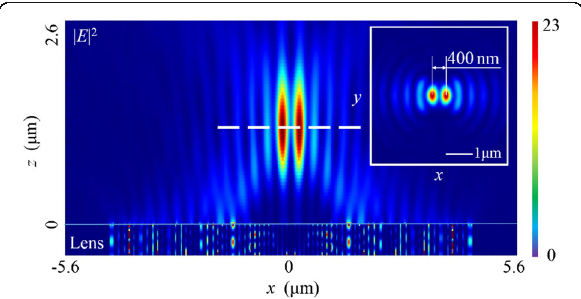
Fig. 3 Intensity distribution pattern of the total electric field | E | 2 in the case of linearly polarized incident light. The inset shows the intensity pattern in the focal plane. The focal length is 1215 nm (a deviation of 6.54%). The FWHMs of both foci are ~0.32 λ 0 , with 400 nm apart from each other, and the depth of focus (DOF) is ~1.68 λ